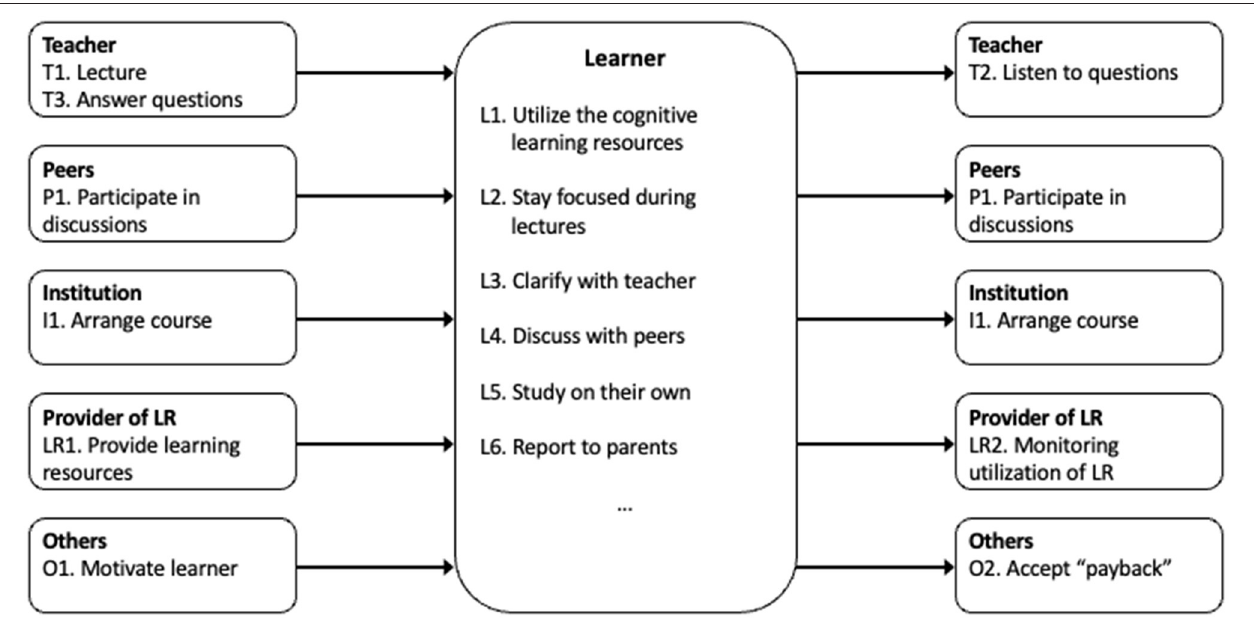
FIGURE 3 | A simplified agent-based flowchart focusing on the learner.